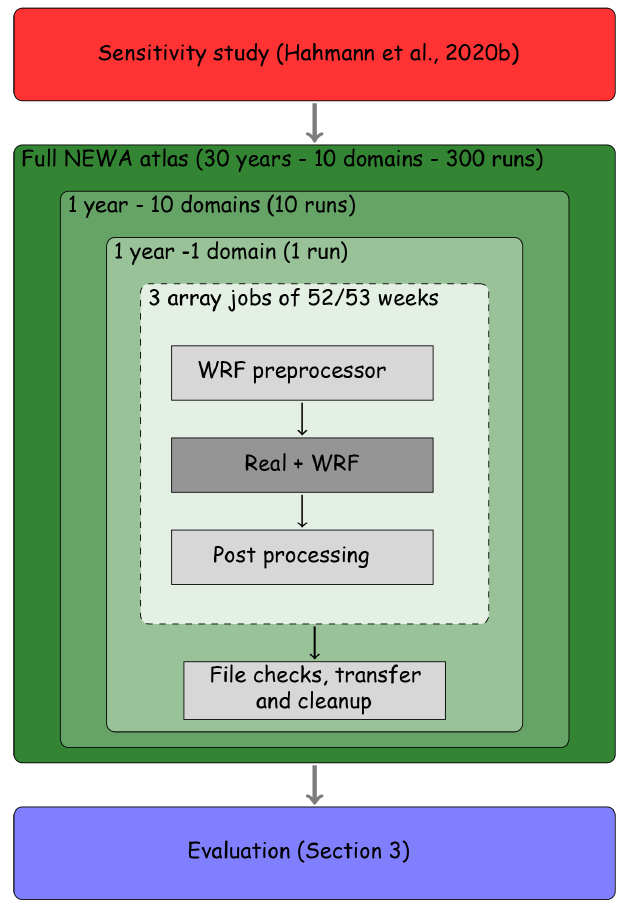
Figure 2. Illustration of how the production run was conducted. The dashed line encloses fully automatic processes, the dark grey box encloses the parallel process (here 480 cores), and light grey boxes enclose serial